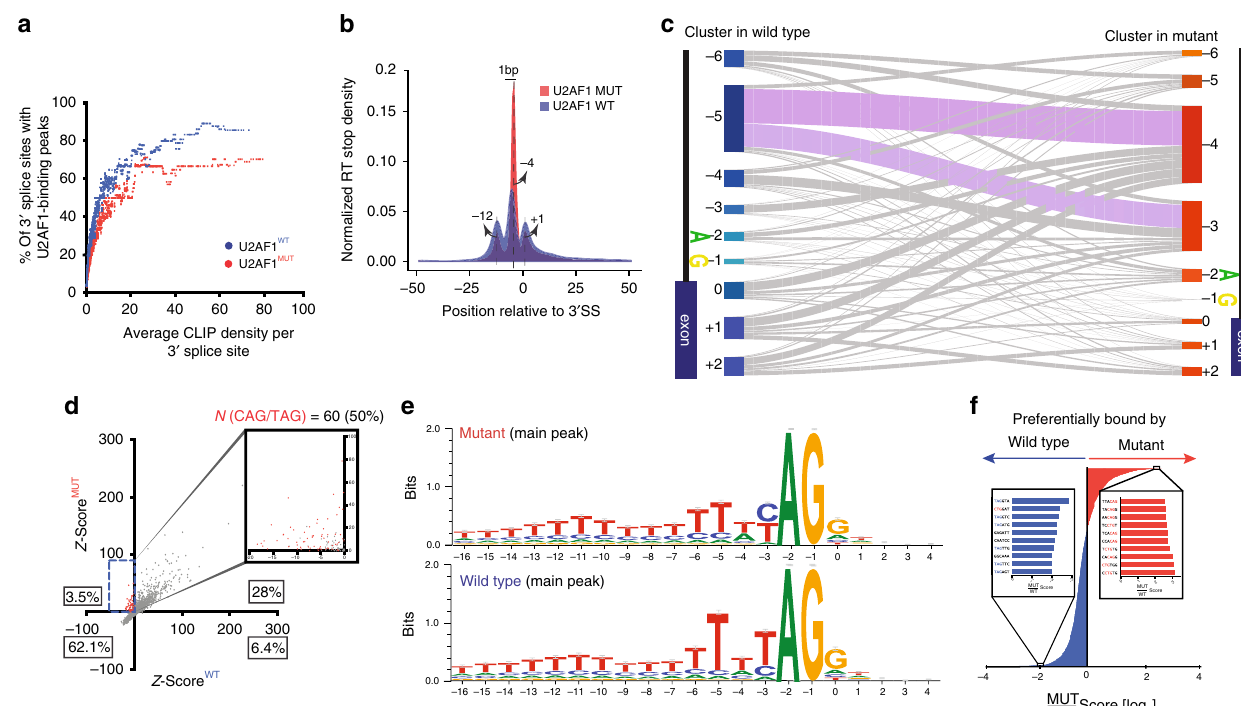
Fig. 3 Determining binding speci fi cities of wild-type and mutant U2AF1. a U2AF1 binds a subset of 3 ’ SSs. Maximum-likelihood analysis was utilized to determine the 3 ′ SS occupancy of wild-type and S34F mutant U2AF1. Each dot represents an average occupancy of a group of 40 genes, in relation to average CLIP density per 3 ′ SS. b Metagene analysis of wild-type and S34F mutant U2AF1 binding interactions to pre-mRNA 3 ′ SSs. Normalized RT-stop density is shown across 3 ′ SS positions on the x -axis. c RT stops >10 were assigned to clusters de fi ned from a window of 3 ′ SSs of − 6 to + 2 nucleotides utilizing 3 ′ SS annotation fi les. The cluster assignments for wild-type and mutant samples are shown in left and right, respectively. d Z-scores were generated based on random hexamer nucleotide motif frequencies bound to wild-type and S34F mutant U2AF1. A subset of Z-scores showing enrichment of 50% of the hexamers bound to mutant U2AF1 for CAG and its reverse complement CTG trinucleotides. e WebLogos depicting binding preferences of wild-type and mutant U2AF1 for the main peaks in b . Position 0 is the intron exon junction depicted by the fi gure. f Generation of a preferential binding score to wild-type and mutant U2AF1. The top 10 scoring hexamers and its common trinucleotide sequences preferentially bound to mutant U2AF1 and wild-type U2AF1 are shown in red and blue,